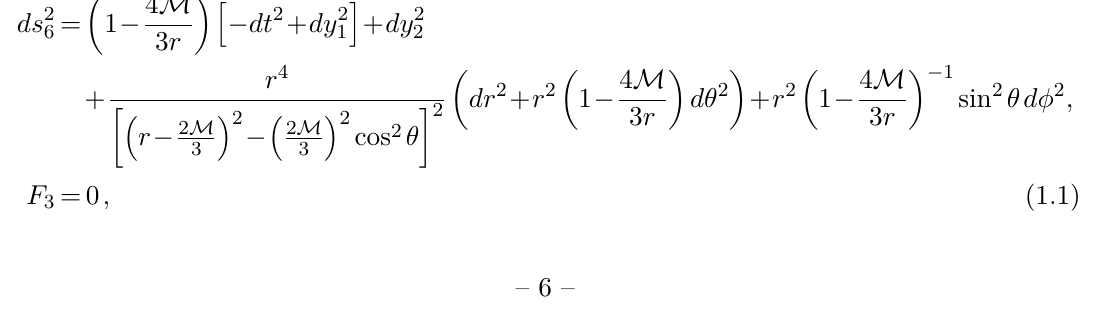
Figure 4 . Redshift factor of the neutral three-bubble solutions with M (cid:29) R y The redshift is almost indistinguishable from the BPS/anti-BPS black hole bound states but the divergences are resolved by the two non-BPS bubbles replacing the extremal